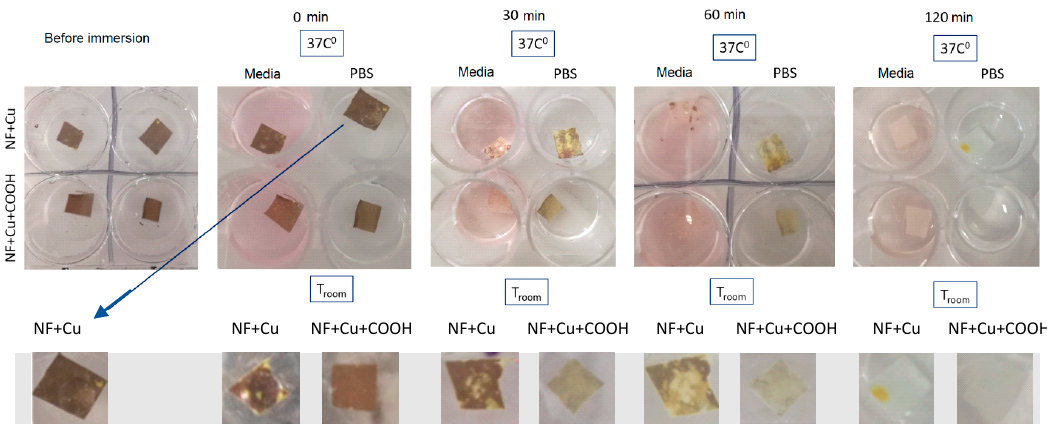
Figure 9. Pictures of PCL ‐ Cu (denoted NF + Cu) and PCL ‐ Cu ‐ COOH (denoted as NF + Cu + COOH) after soaking in PBS and culture media.